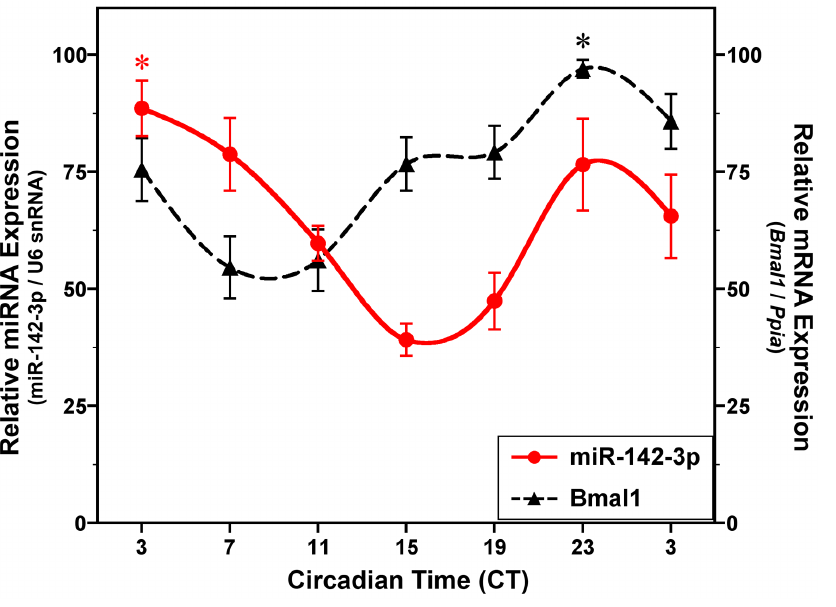
Figure 1. Temporal patterns of miR-142-3p and Bmal1 expression in the mouse SCN. Symbols denote real-time PCR determinations (mean 6 SEM) of miR-142-3p (red) and Bmal1 mRNA (black) levels at 4-hour intervals in the SCN (n=4-5) of mice exposed to constant darkness (DD). The plotted values correspond to the ratios of miR-142-3p signal normalized to U6 snRNA levels and of Bmal1 / Ppia mRNA signal in which the maximal value for each gene was set at 100%. Asterisks indicate time points during which peak levels were significantly greater ( p , 0.05) than those observed during preceding or succeeding minima.